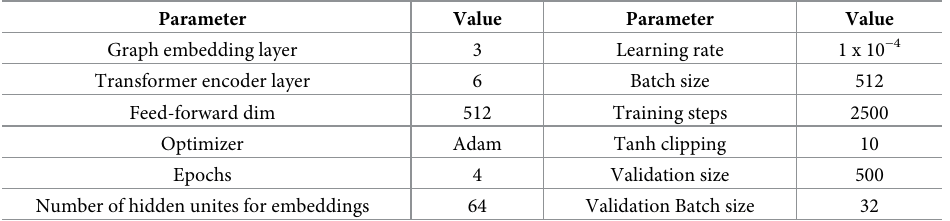
Table 4. Hyperparameters used for training of large